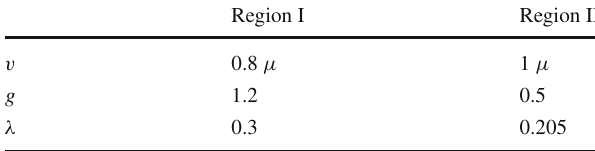
Table 1 Parameter values used in the spectral density functions Region I Region II